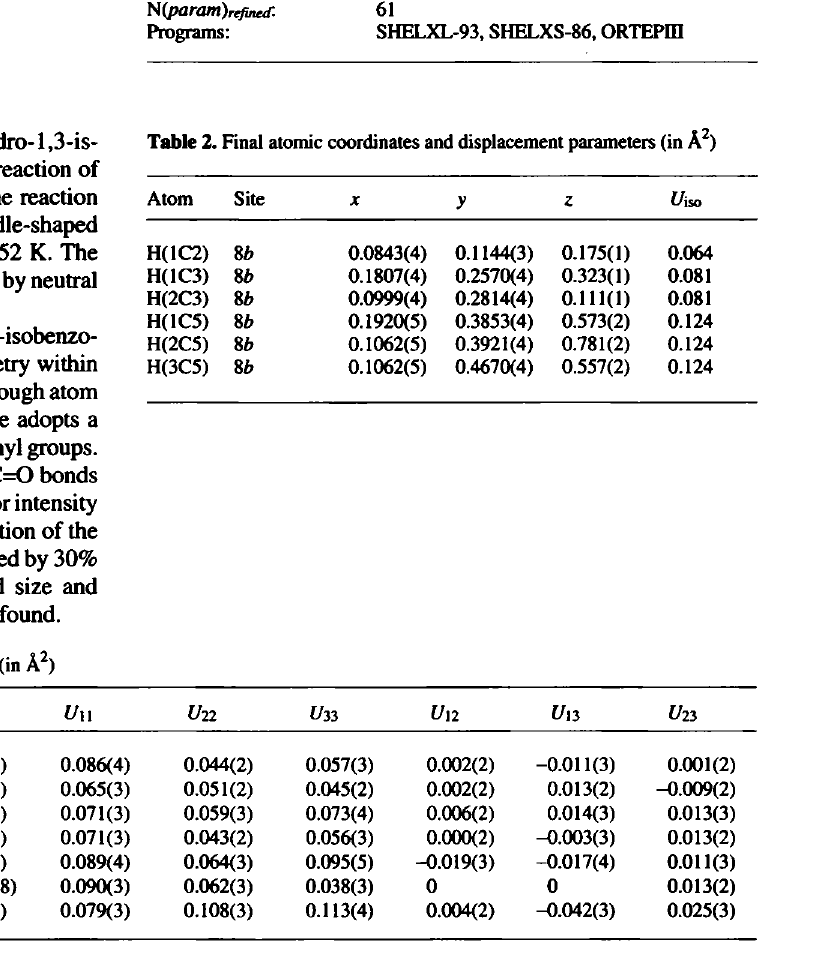
Table 1. Parameters used for the X-ray data collection Crystal: